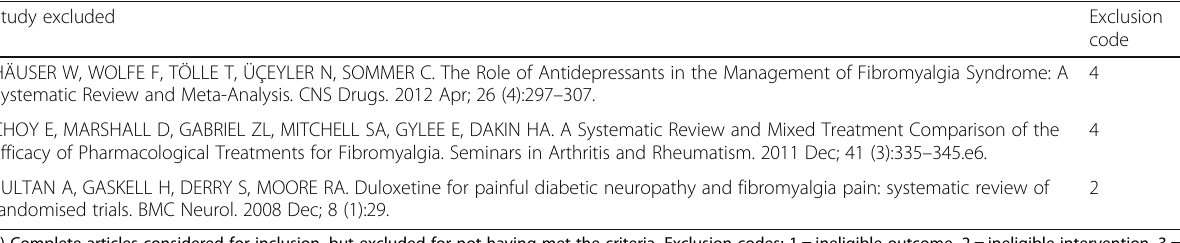
Table 2 Studies excluded for not having met the eligibility criteria Study excluded Exclusion